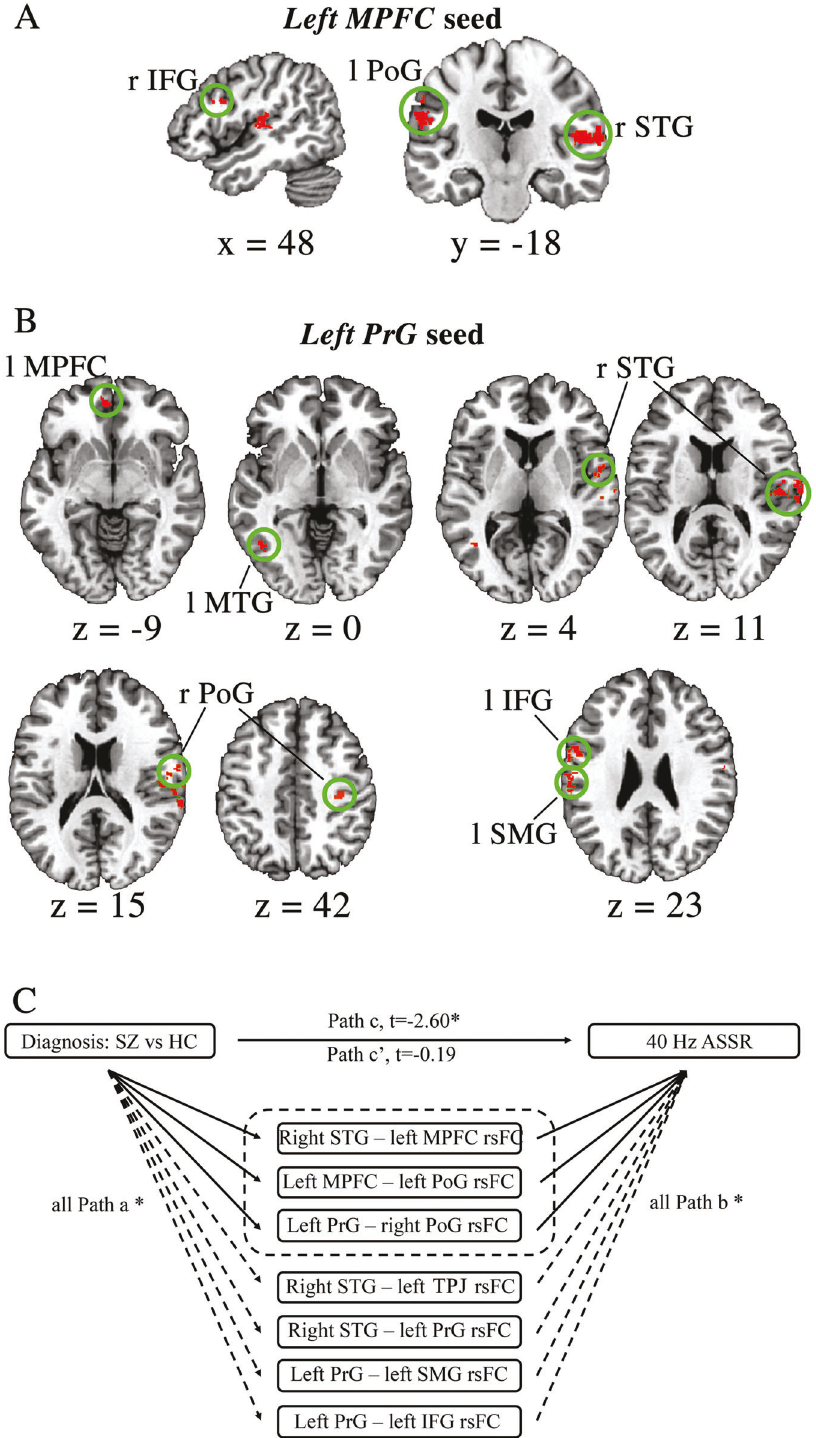
Fig. 3 Gamma-band auditory steady-state response (ASSR) related resting-state functional connectivity (rsFC) with left medial prefrontal cortex (MPFC) or left precentral gyrus (PrG) seeds and the mediation analysis model. A Left MPFC -seeded rsFC with right STG, left postcentral gyrus (PoG), and right inferior frontal gyrus (IFG) signi fi cantly predicted 40 Hz ASSR in combined groups and within each group. B Left PrG -seeded rsFC at left supramarginal gyrus (SMG), left IFG, right PoG, left middle temporal gyrus (MTG), and left MPFC signi fi cantly predicted larger 40 Hz ASSR. Left is shown on the left side of the MRI image. C The signi fi cant effects of diagnosis (i.e., the differences of 40 Hz ASSR between the two diagnostic groups) on 40 Hz ASSR (path c) were nearly fully mediated by the top three rsFC (path c ’ not signi fi cant). STG superior temporal gyrus, MPFC left medial prefrontal cortex, PoG postcentral gyrus, PrG precentral gyrus, SMG supramarginal gyrus, IFG inferior frontal gyrus, SZ patients with schizophrenia, HC healthy controls. Seed region was written in italic. * p <